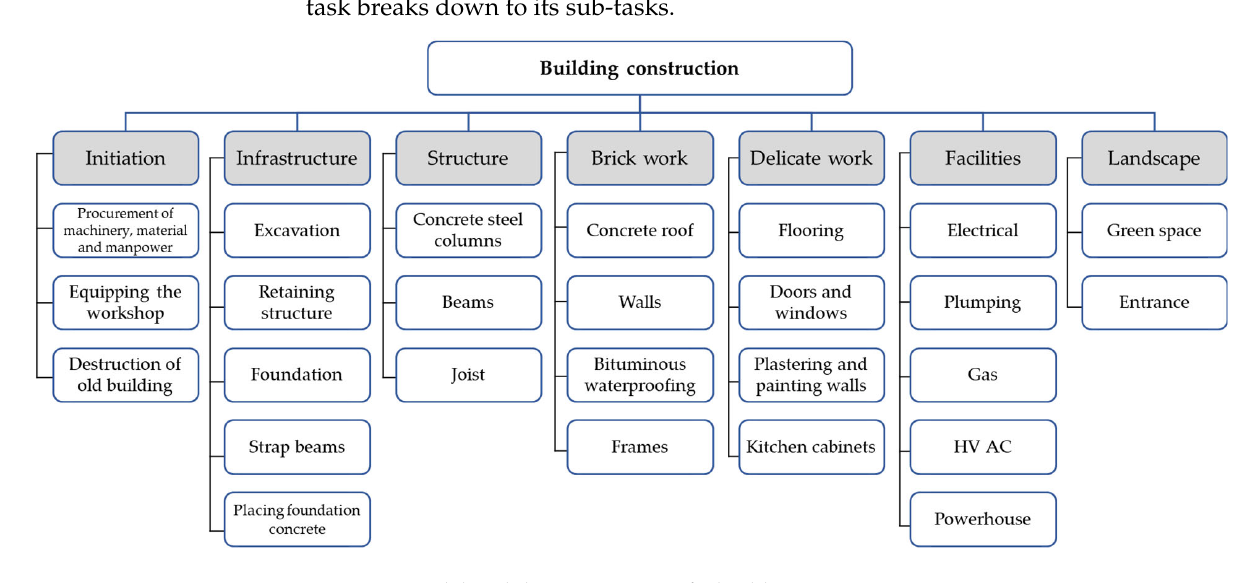
Figure 3. Work breakdown structure of a building construction project.